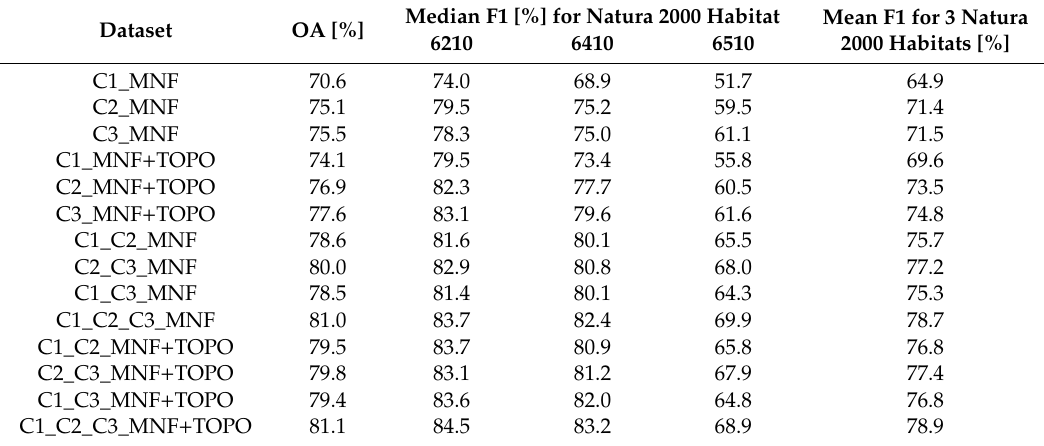
Figure 3. Overall accuracies for each dataset in three campaigns (C1, C2, C3—campaign number, MNF—minimum noise fraction, TOPO—topographic indices). Table 4. The results of all classifications (C1, C2, C3—campaign number, MNF—minimum noise fraction, TOPO – topographic